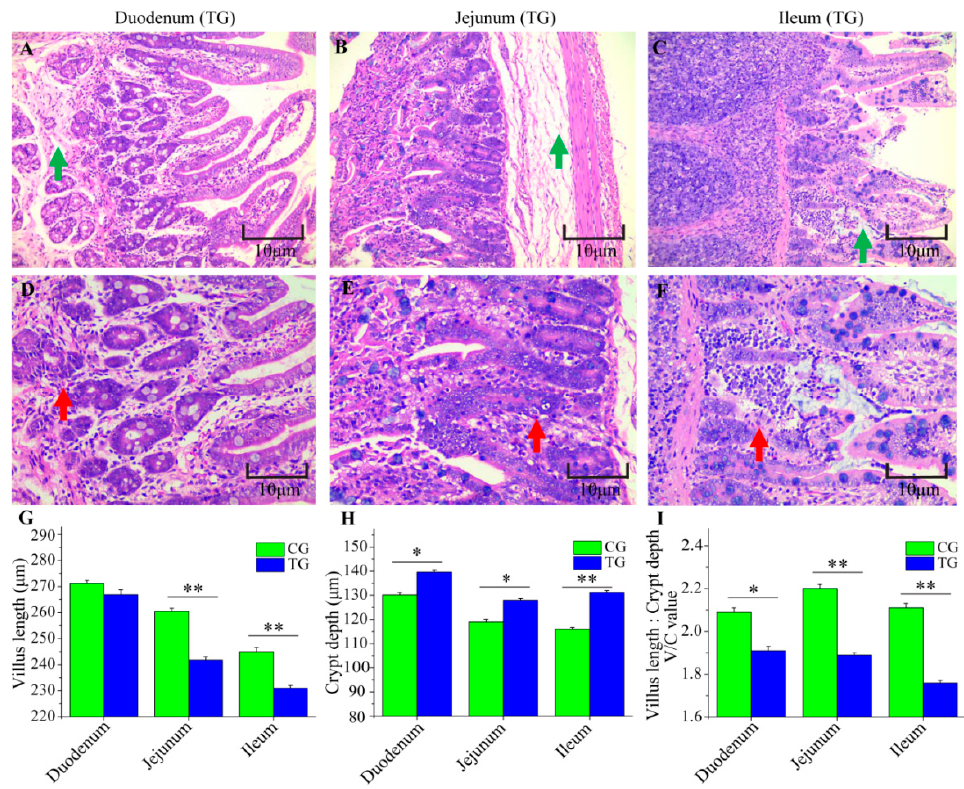
Figure 2. Changes in the small intestine. ( A ) Edema of the lamina propria and submucosa (green arrow); ( B ) Edema of the lamina propria and submucosa (green arrow); ( C ) Edema of the lamina propria (green arrow); ( D ) Inflammatory cell infiltration (red arrow); ( E ) Infiltration with neutrophil granulocytes (red arrow); ( F ) Inflammatory cell infiltration (red arrow); ( G )Villus height; ( H ) Crypt depth; ( I ) The ratio of villus width/crypt depth. Asterisk above bars indicates a significant difference (* p < 0.05, ** p < 0.01). Data are shown as mean ± SE of thirty replicates.